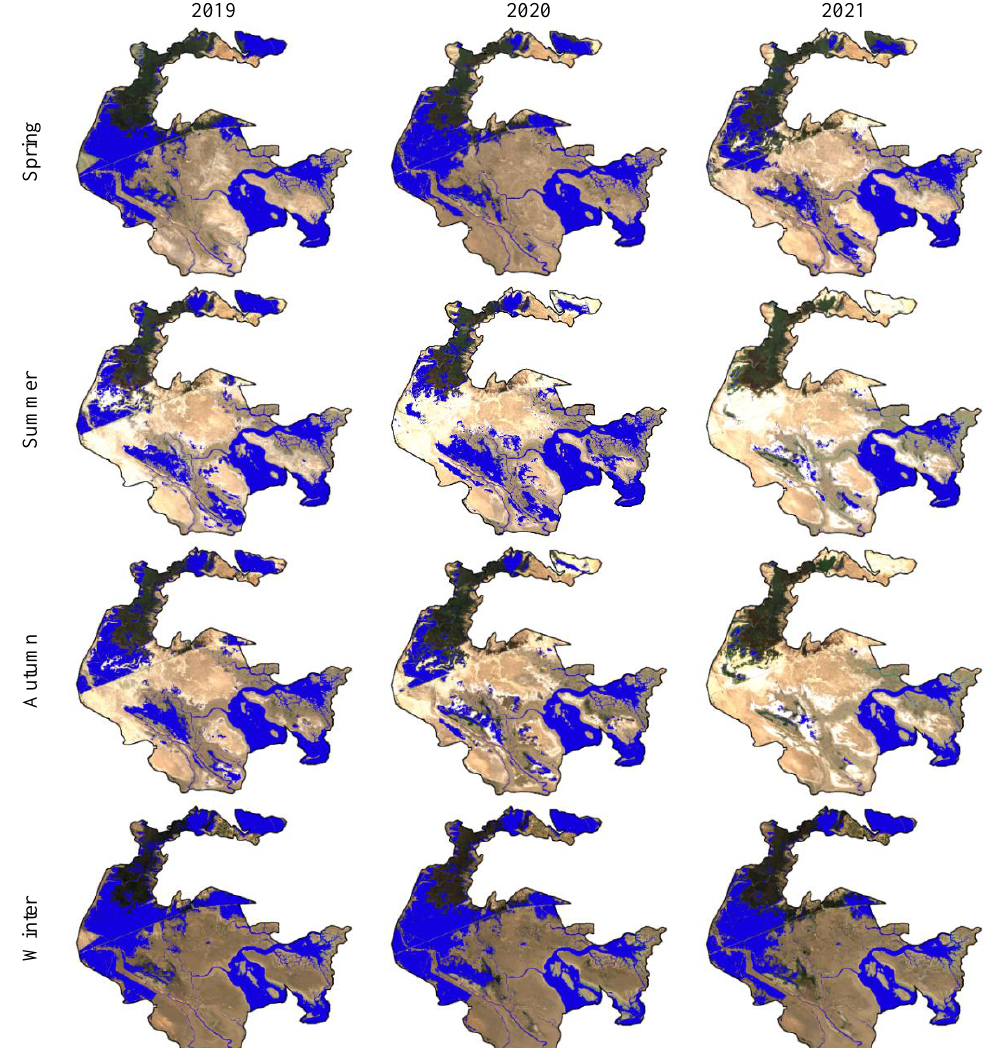
Figure 3. The seasonal surface water body distribution of ISW from 2019 to 2021. According to the Figures, water bodies are scattered mainly in the eastern and western parts of ISW, regardless of the different seasons of the year, while they are smaller in the central